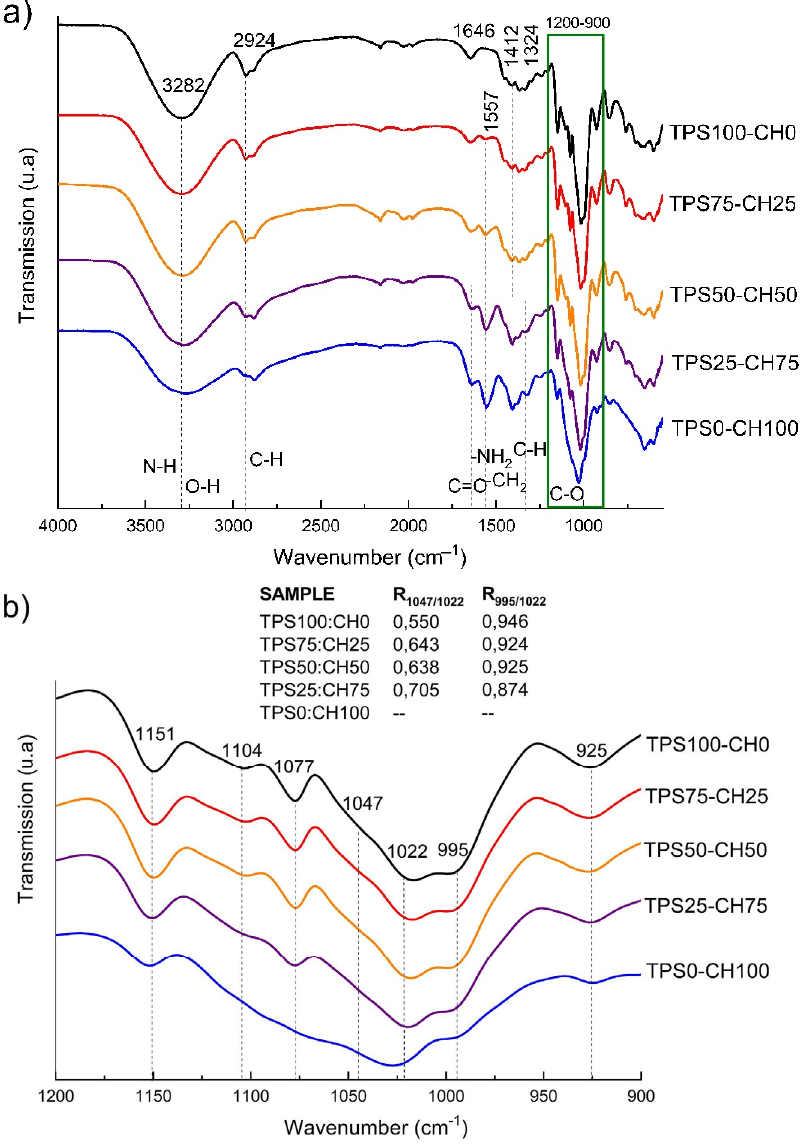
Figure 1. ( a ) Attenuated total reflection–Fourier transform infrared (ATR–FT-IR) spectra of starch-chitosan films. ( b ) Amplified region between 1200 cm − 1 an 900 cm − 1 ; this relates the values of R 1047/1022 and R 995/1022 of starch-chitosan films.